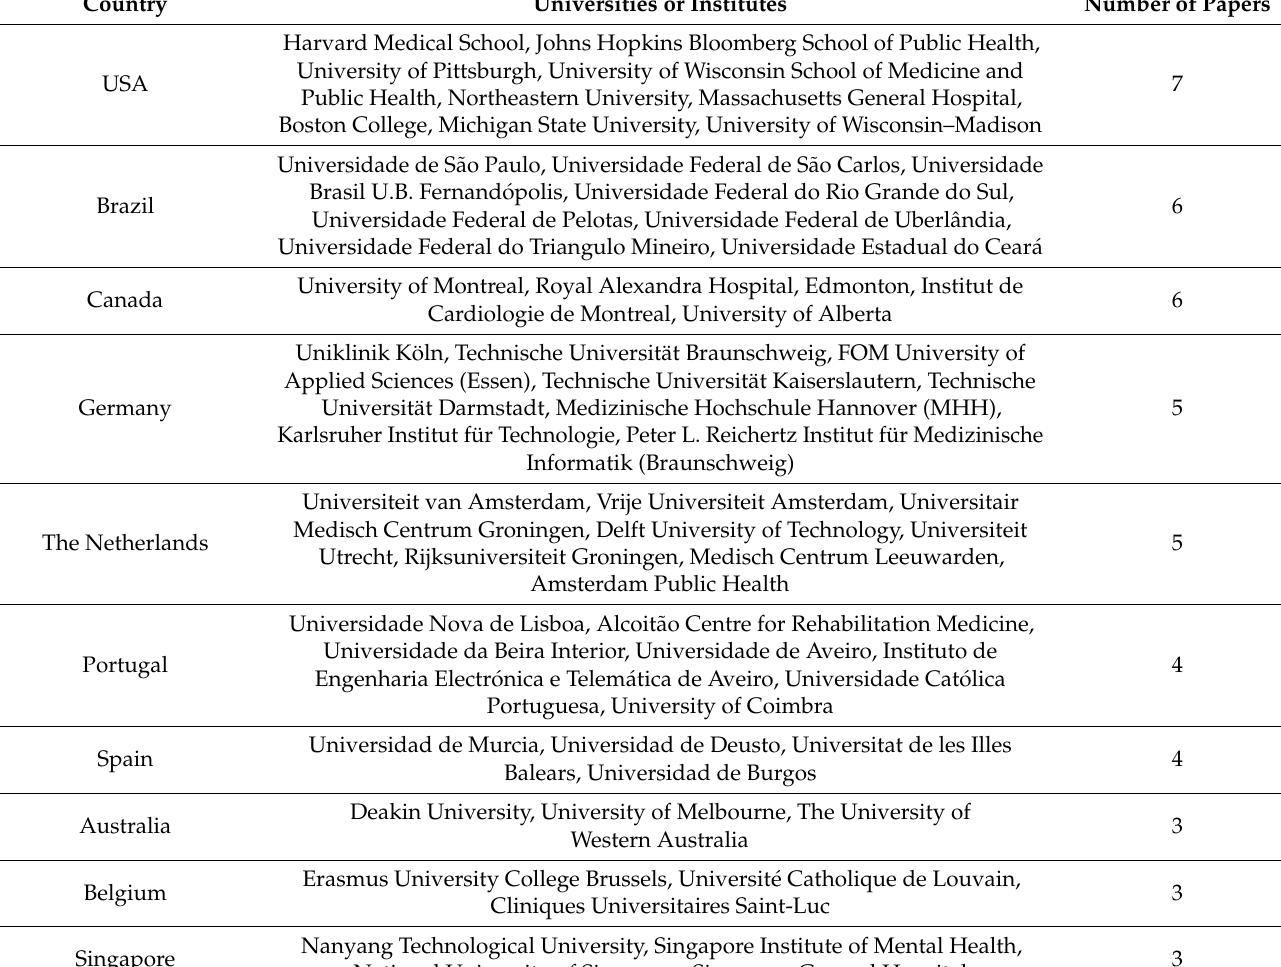
Table 5. Distribution of papers by countries and affiliations of authors (more than two studies). Country